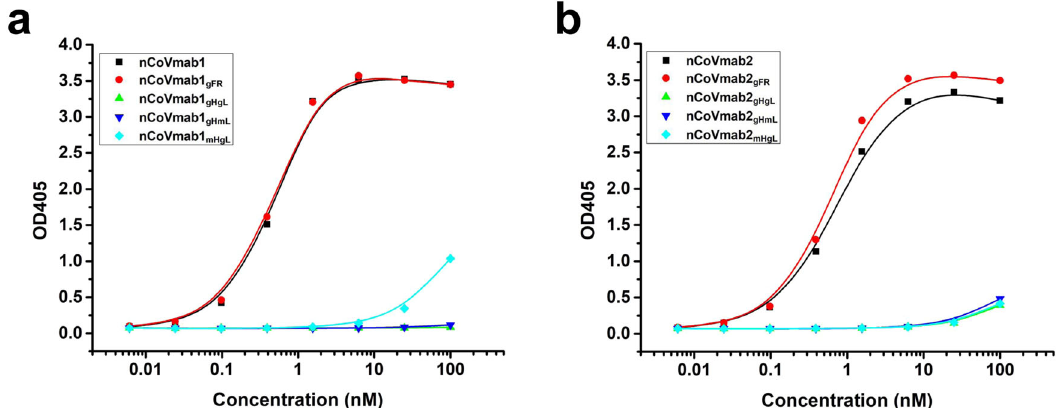
Fig. 6 Recognition of the RBD by the germline formats of nCoVmab1 and nCoVmab2. a nCoVmab1 and its germline formats. b nCoVmab2 and its germline formats. The SHMs on the FR did not change the binding activities in either nCoVmab1 or nCoVmab2. The SHMs on the CDRs dramatically reduced binding. For nCoVmab1, maturation of the heavy chain was important for the acquisition of preliminary binding activities. In nCoVmab2, the germline format might initiate binding. The synergetic maturation of both the heavy and light chains was crucial for high-af fi nity binding. The experiment was performed with duplicate samples. Data are average values of two